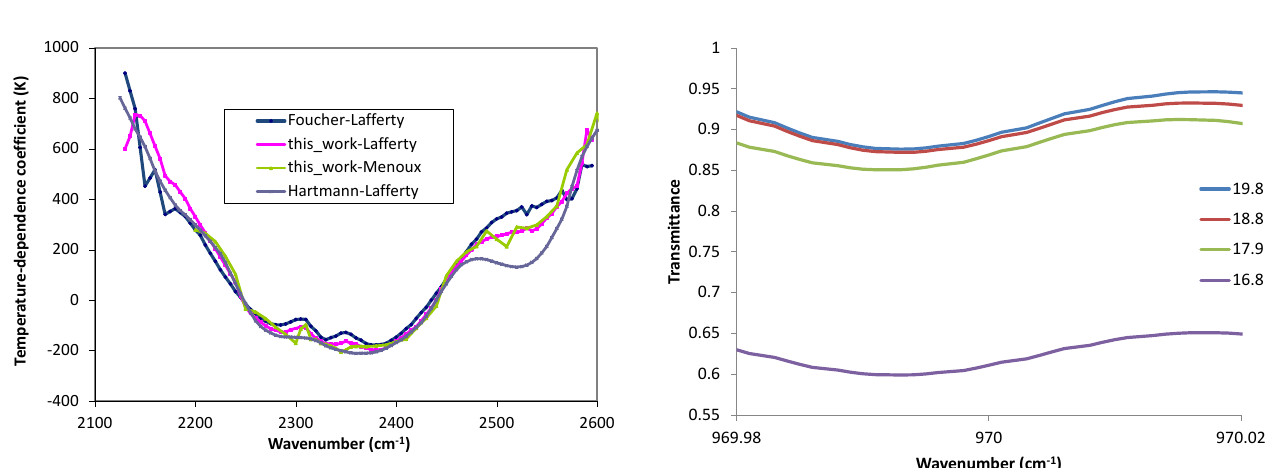
Figure 2. Observed transmittance spectra in the vicinity of the wavenumber used for cloud detection (970.00cm − 1 ) at a series of THs listed in the legend (inkm) during sunrise 29818 (8 ◦ S, 67 ◦ E) on 24 February 2009. The sharp decrease in transmittance between THs of 16.8 and 17.9km is due to cloud opacity at the